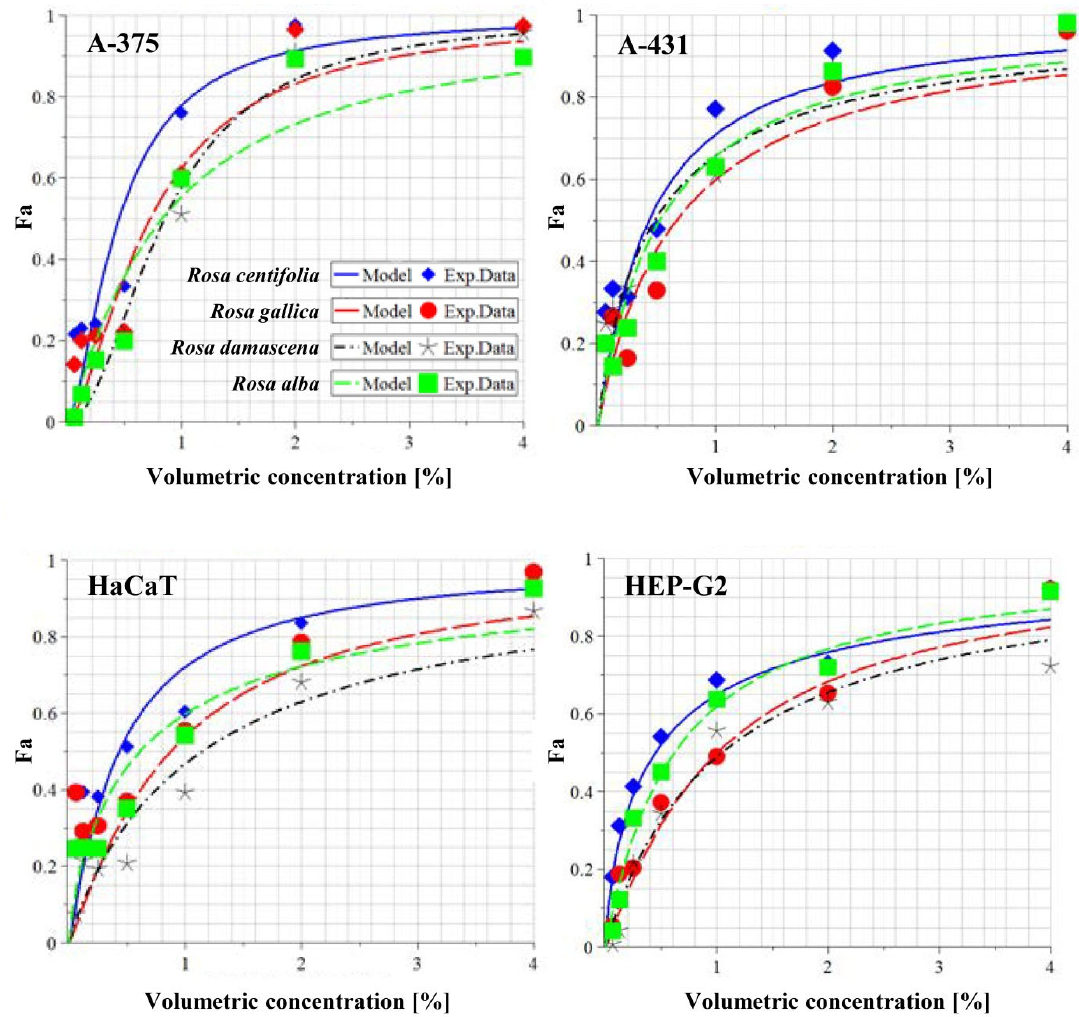
Figure 2. Cytotoxic activity of wastewaters from Rosa spp. on non-tumorigenic and tumorigenic cell lines—curve model. Legend: HEP-G2: liver adenocarcinoma (stage I); HaCaT: normal human keratinocytes; A-375: malignant melanoma; A-431: epidermoid carcinoma of the skin; Fa: antiproliferative effect (expressed as fraction of the untreated control). The curves describing the experimental data are presented on the plots with different types of lines and colors. The experimental data are presented as points with different shapes and colors corresponding to the color of the respective curve. Table 4. Comparison of the cytotoxicity of wastewaters obtained from four different rose species on non ‐ tumorigenic and tumorigenic cell lines, based on selectivity index values.